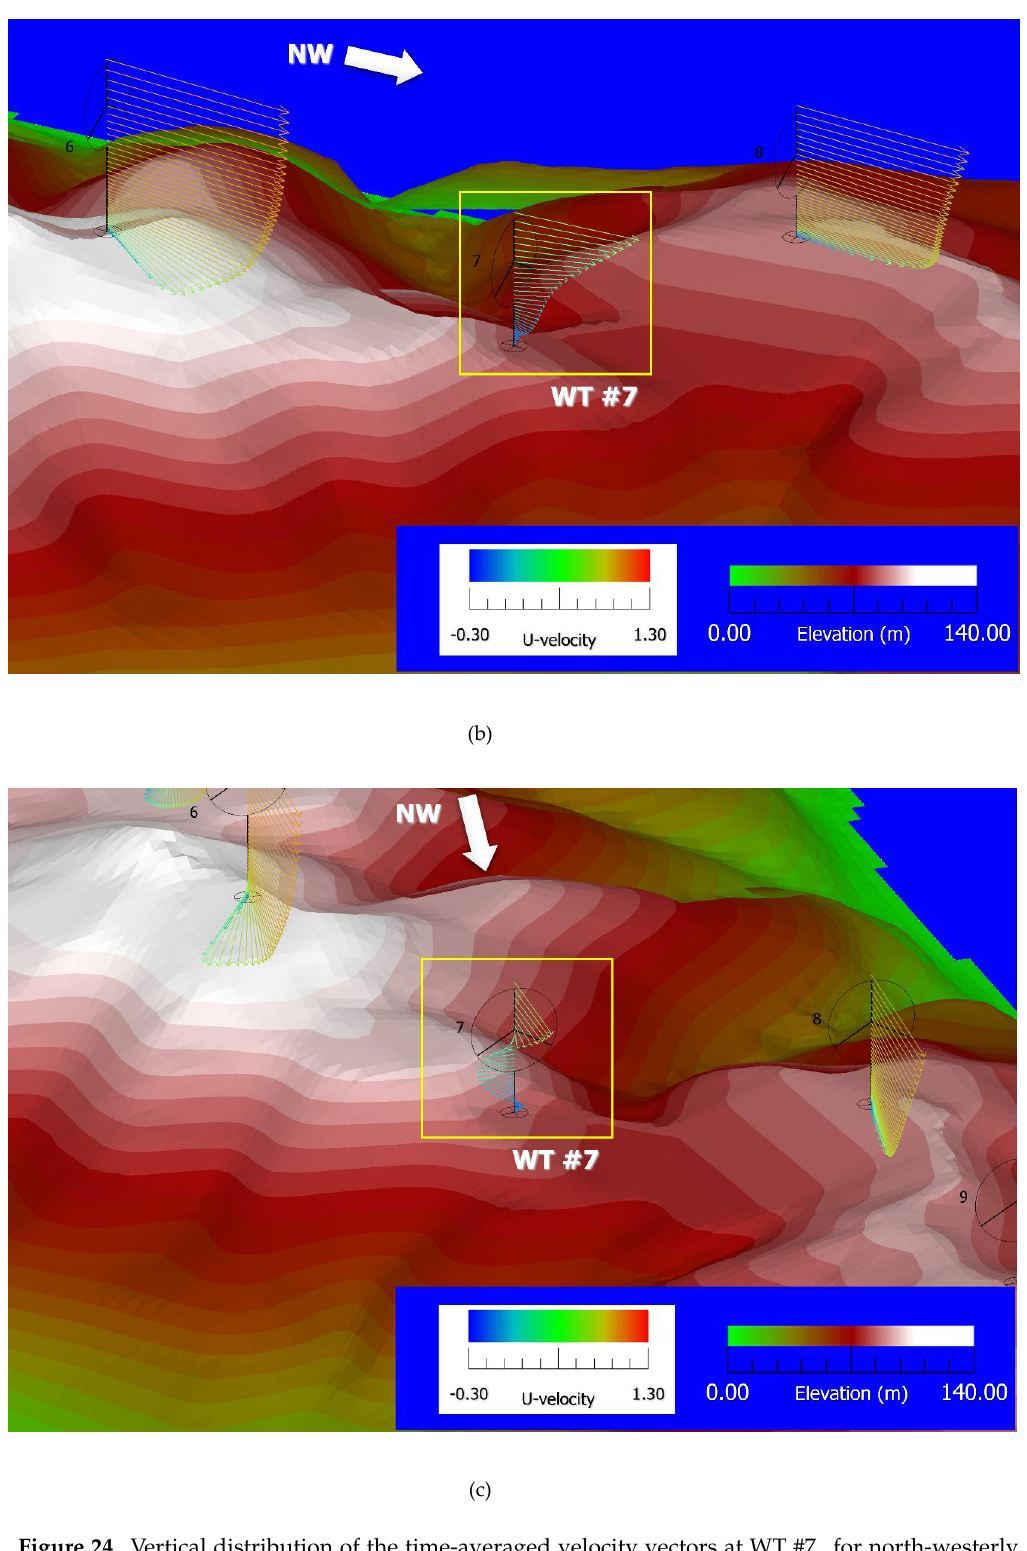
Figure 24. Vertical distribution of the time-averaged velocity vectors at WT #7. for north-westerly wind: ( a ) Oblique map view, ( b ) side view, and ( c ) rear view. This flow visualization is based on the numerical results using a 5 m grid.